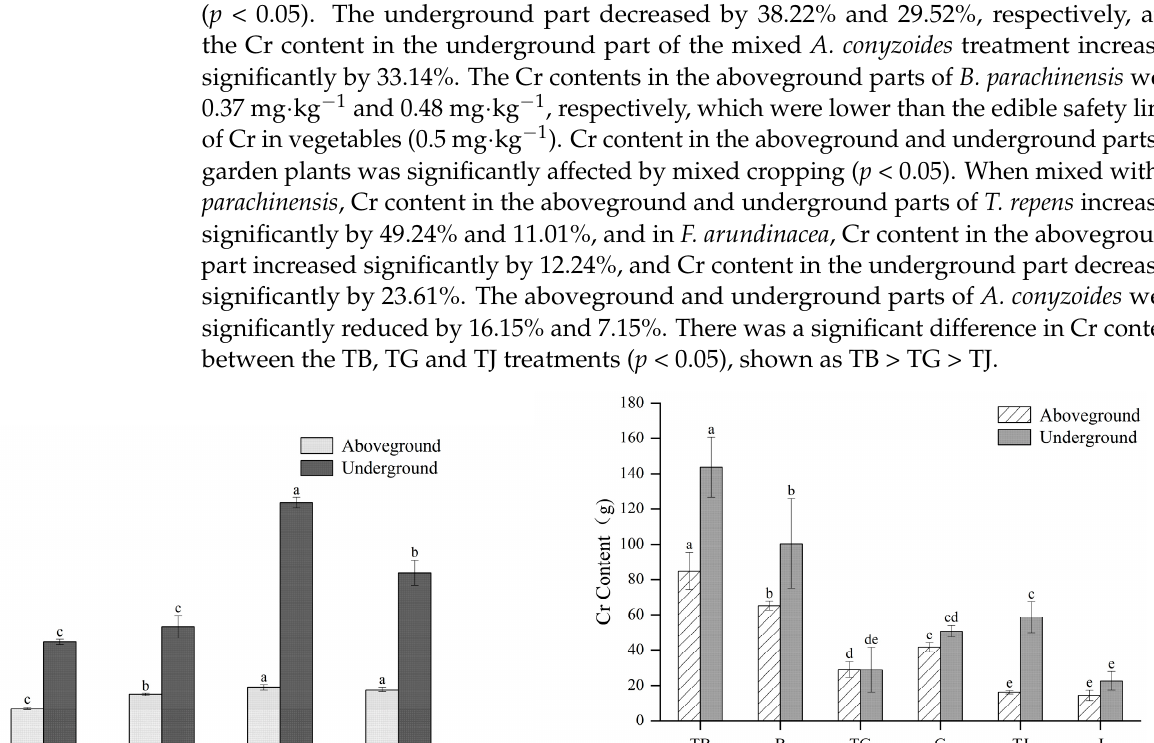
The column in the figure indicate that the difference between different treatments is significant ( p <